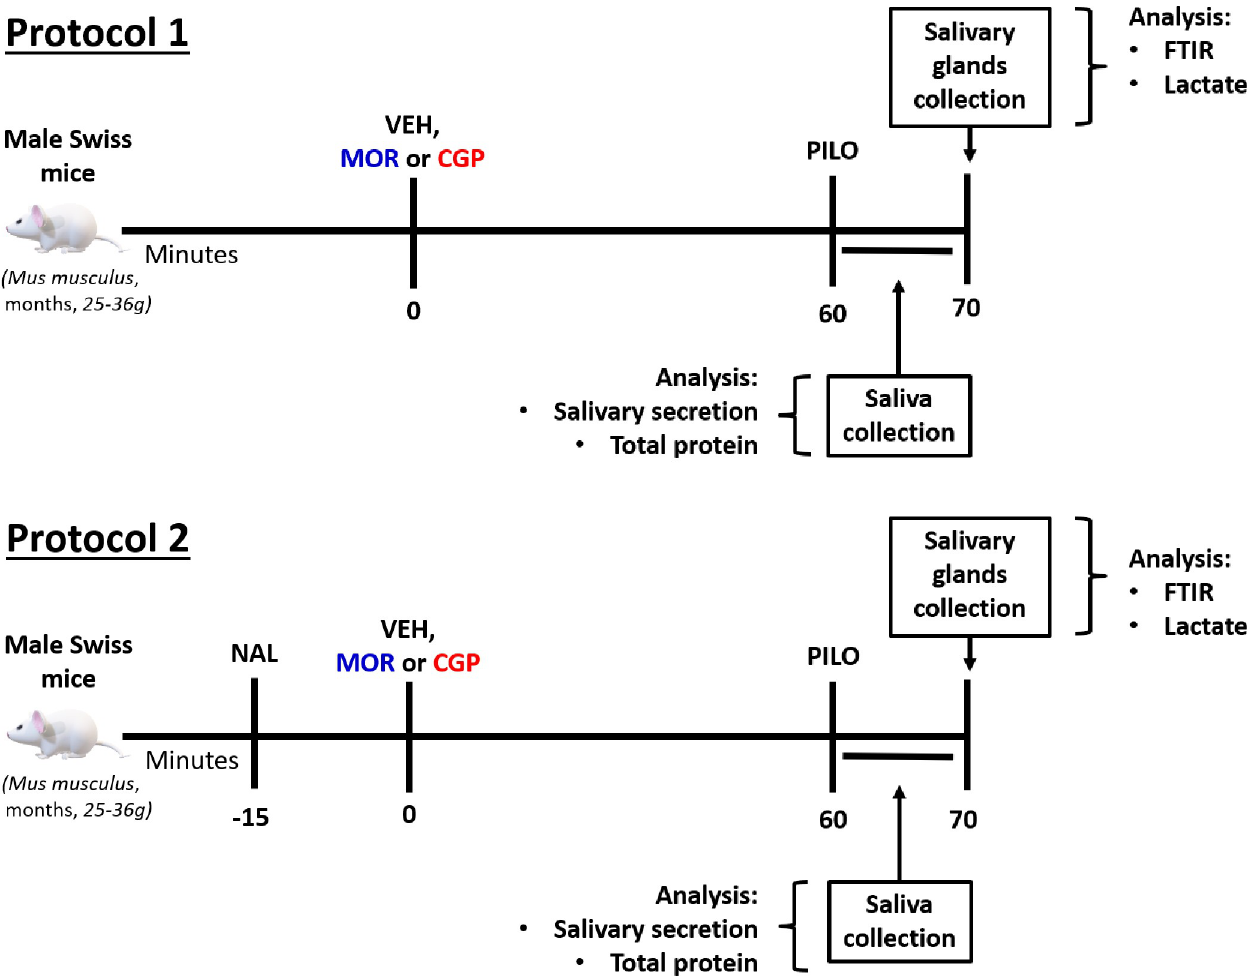
Fig 1. Experimental design of the acute treatment with vehicle, morphine or CGP in male Swiss mice in two protocols with or without the previous administration of naloxone. In protocol 1, mice were treated acutely with vehicle (VEH, NaCl, 0.9%), morphine (MOR, 17.5 μ mol kg -1 , ip) or CGP (1 μ mol kg -1 , ip). After one hour of treatment, a parasympathetic stimulus with pilocarpine (PILO, 2 mg kg -1 , ip) was performed during 10 min for salivary secretion and salivary composition analysis. Immediately after saliva collection, submandibular glands were removed and storage at − 80˚C. The CGP and morphine effects on submandibular gland molecular composition were observed by Attenuated total reflectance Fourier transform infrared (ATR-FTIR) spectroscopy and lactate level analysis. In protocol 2, naloxone (15.3 μ mol kg -1 , ip) was administered 15 minutes prior to acute treatment with vehicle, morphine and CGP in order to evaluate the opioid receptors involvement in saliva and submandibular